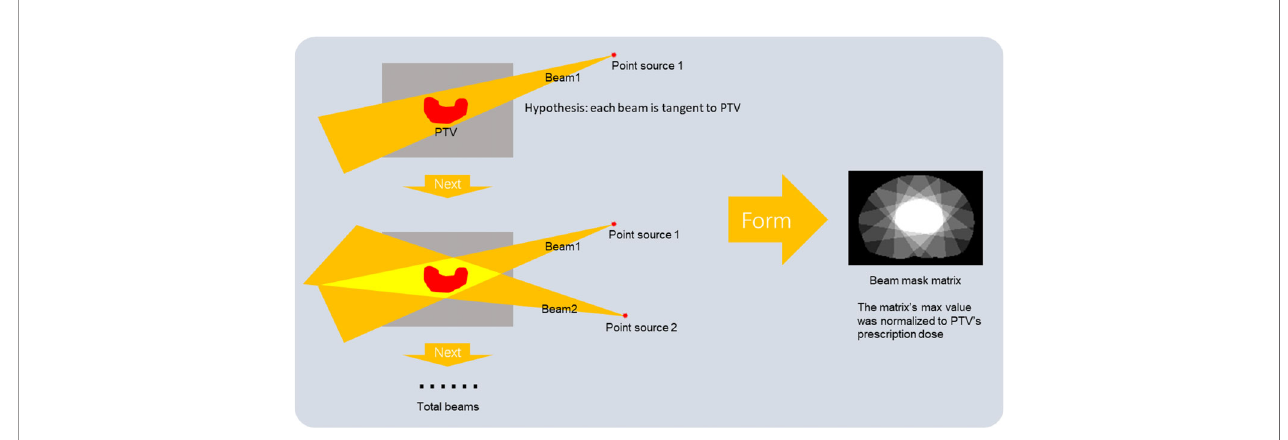
FIGURE 1 | The generation process of beam